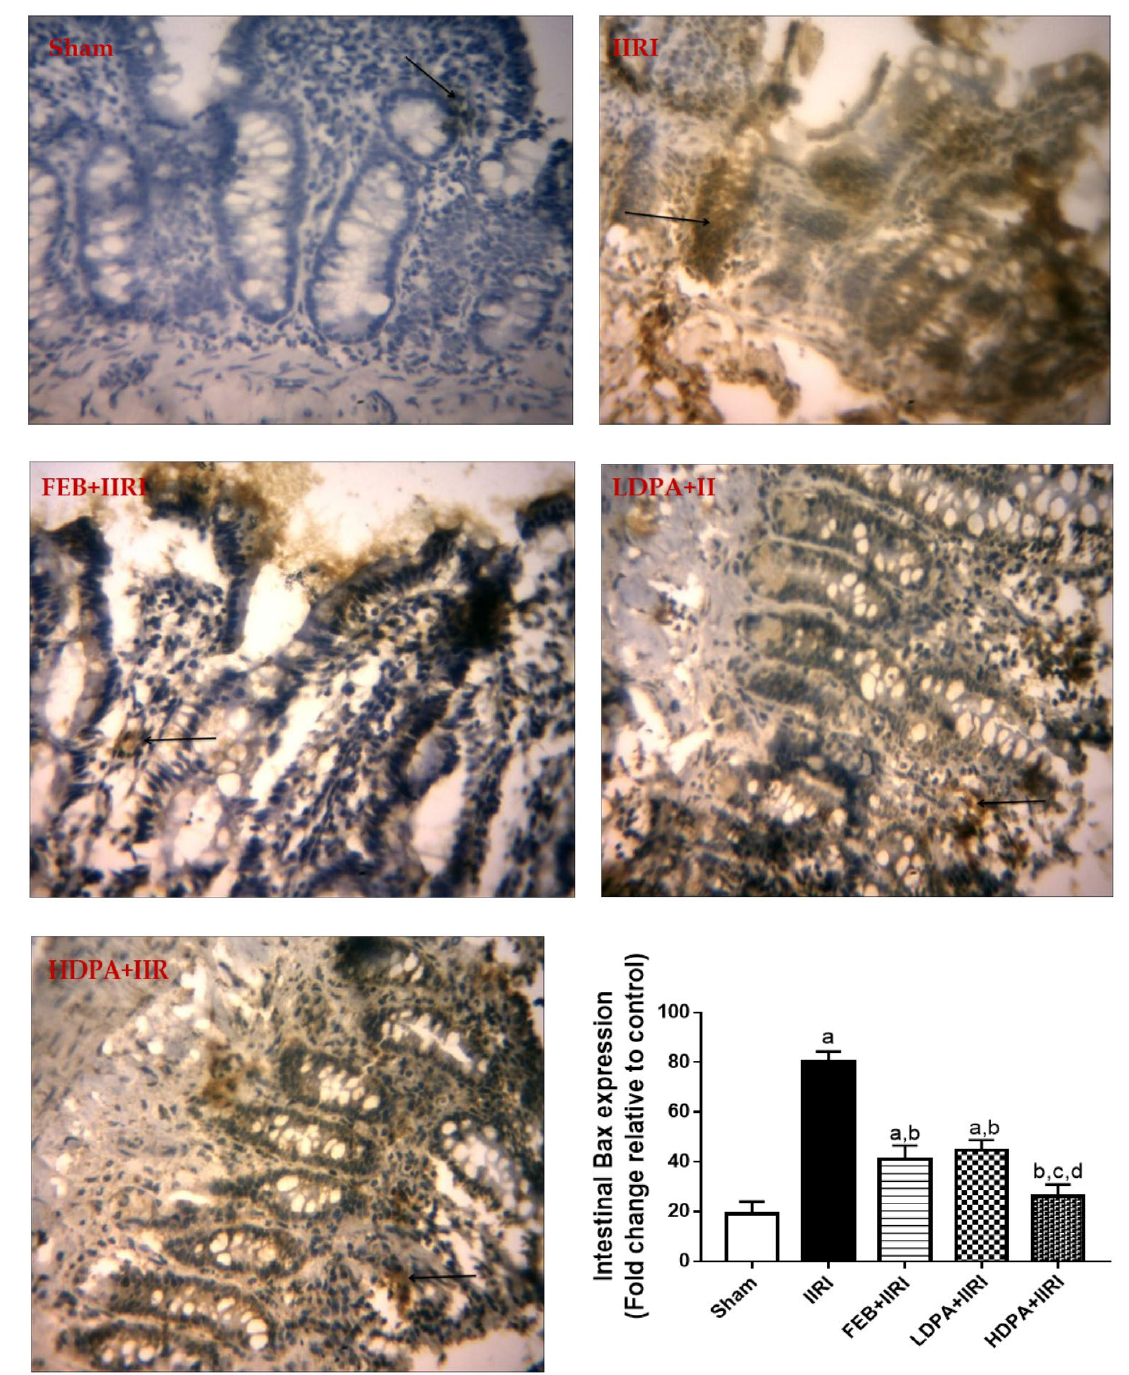
Figure 9. Effect of intestinal ischemia/reperfusion (I/R) and methanolic Phyllanthus Amarus leaf extract on intestinal Bax expression. IIRI: intestinal ischemia/reperfusion injury, FEB: febuxostat, LDPA: low-dose Phyllanthus Amarus, HDPA: high-dose Phyllanthus Amarus, a p < 0.05 versus sham, b p < 0.05 versus IIRI, c p < 0.05 versus FEB + IIRI, d p < 0.05 versus LDPA + IIRI. Values represent the mean for five replicates ± the standard deviation.